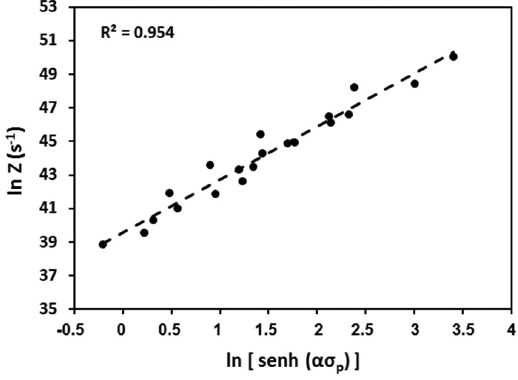
Figure 4. Correlation between the peak stress ( σ Hollomom parameter (Z) showing the fit of experimental data to Equation 8.